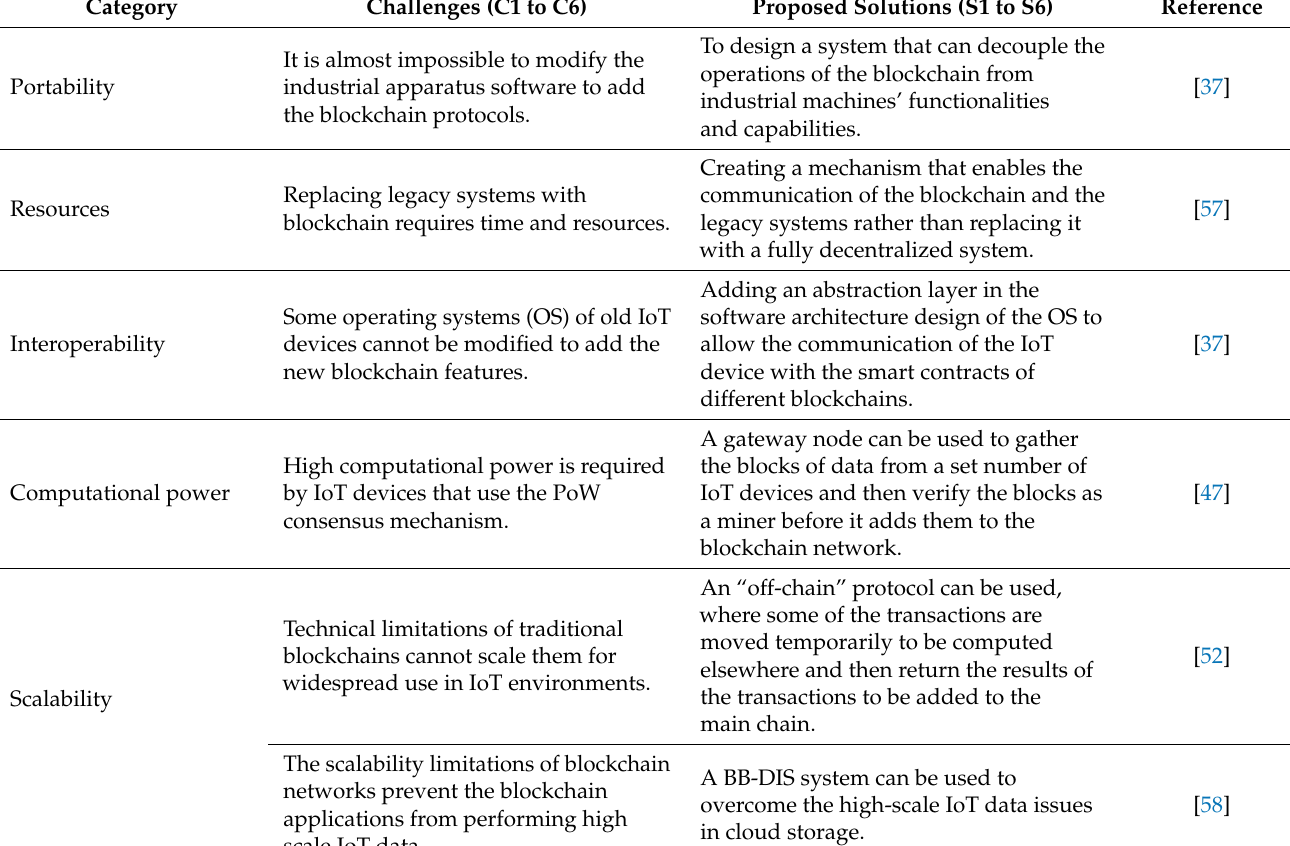
Table 6. Challenges and possible solutions for BC and IoT